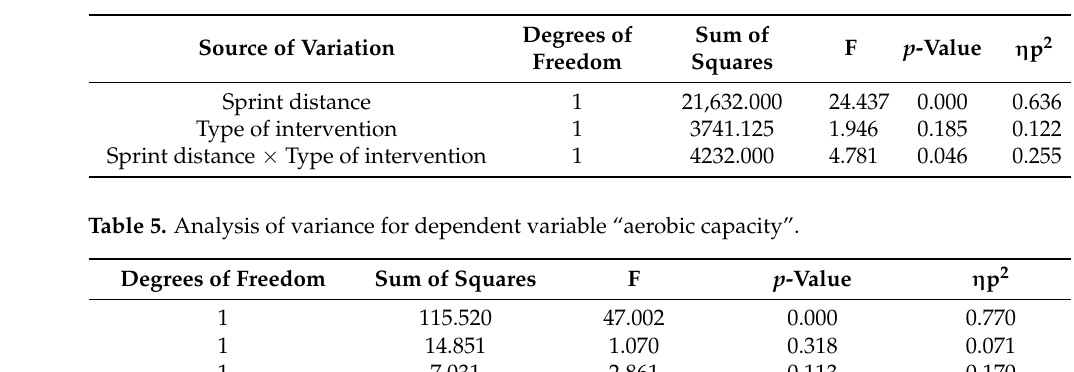
Table 4. Analysis of variance for dependent variable “total sprint distance”.